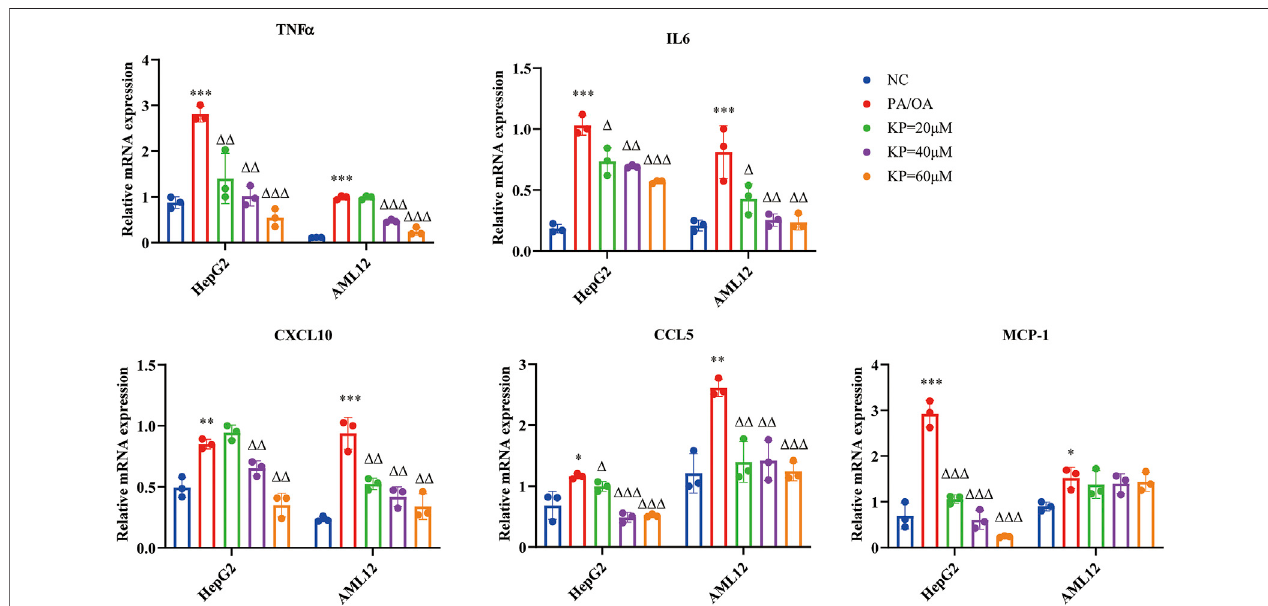
FIGURE7| KPreducedthemRNAexpressionofin fl ammatoryfactors invitro .NC:Normalcontrolgroup,PA/OA:PA/OAgroup,KP (cid:2) 20 µM:KPlowconcentration group, KP (cid:2) 40 µM: KP medium concentration group, KP (cid:2) 60 µM: KP high concentration group. Quanti fi cation of mRNA expression was normalized to β -actin levels. Compared with group NC, *, p < 0.05, **, p < 0.01, ***, p < 0.001; Compared with group PA/OA, △ , p < 0.05, △△ , p < 0.01, △△△ , p <